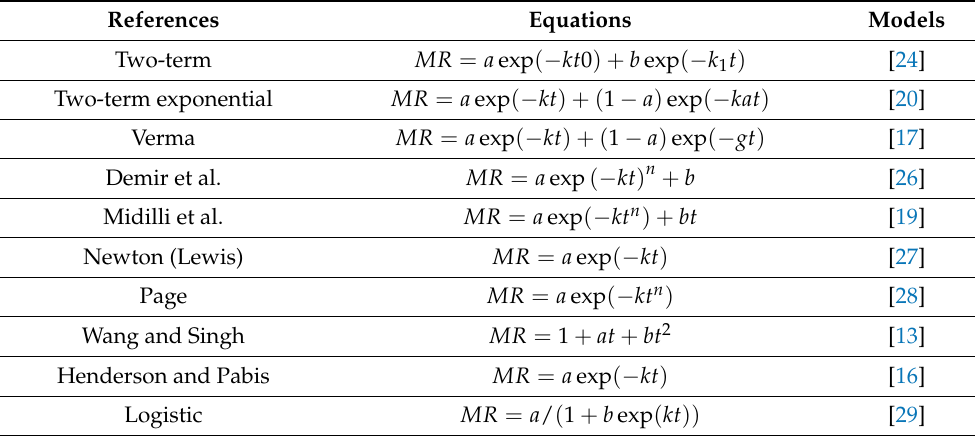
Table 1. Applied models to fit the experimental data MR = 1 + at + bt 2